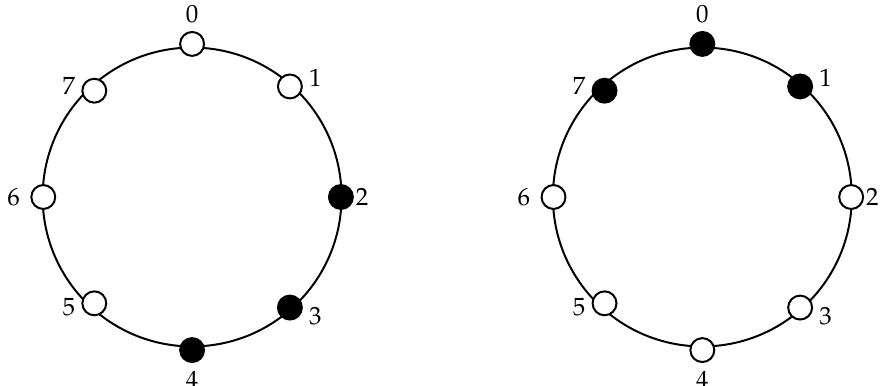
Figure 1. Anyone of filled circles in the left figure represents an intermediate class between [ 1 ] and [ 5 ] ; and in the right figure filled circles represent the same from [ 6 ] to [ 2 ]